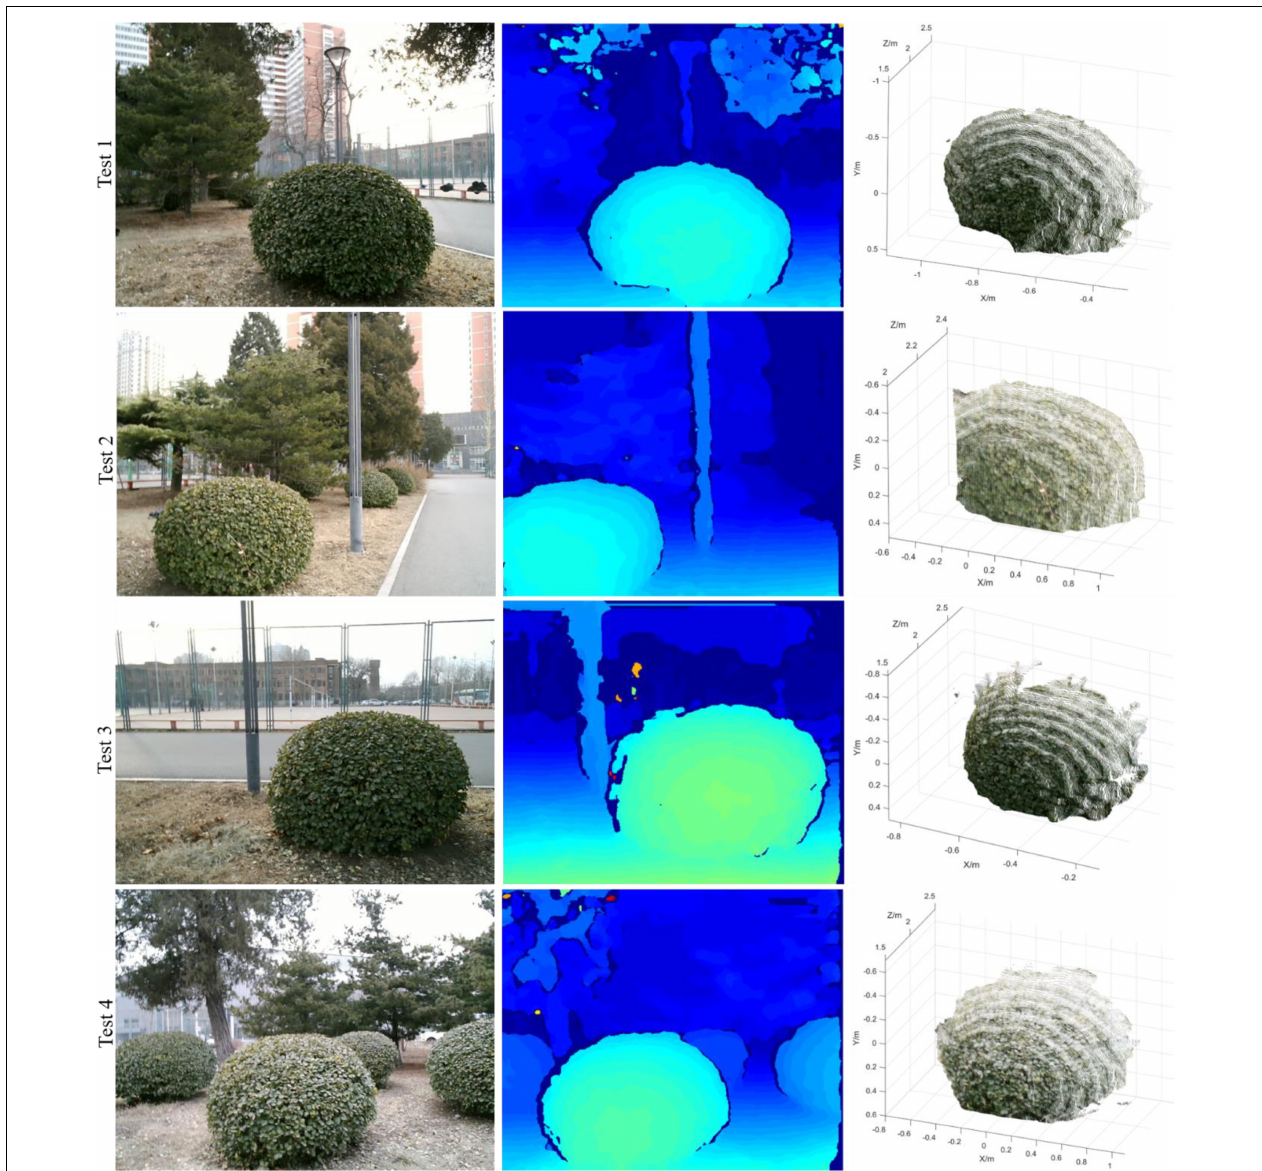
FIGURE 18 | 3D reconstruction result of outdoor